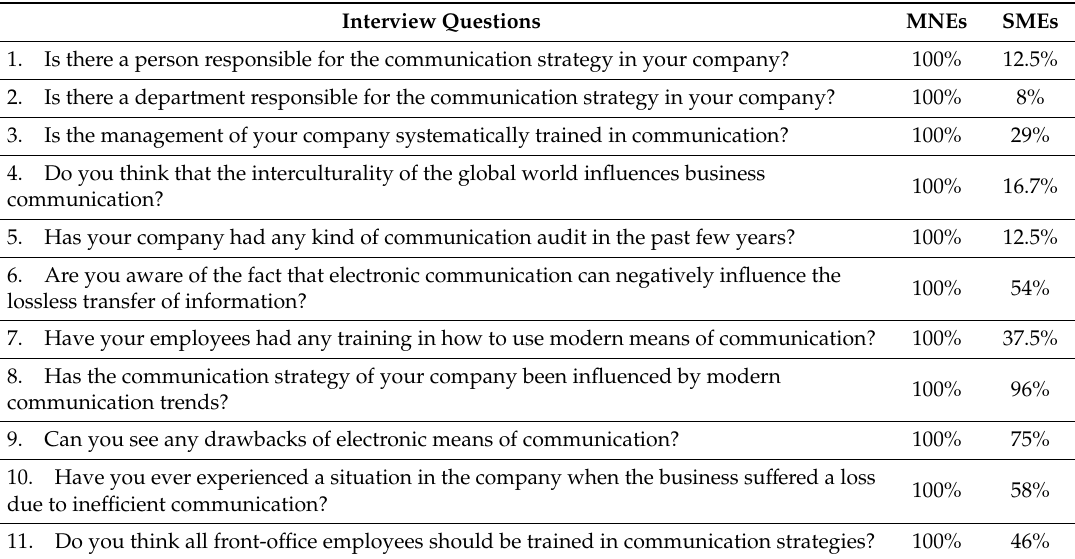
Table 1. The research